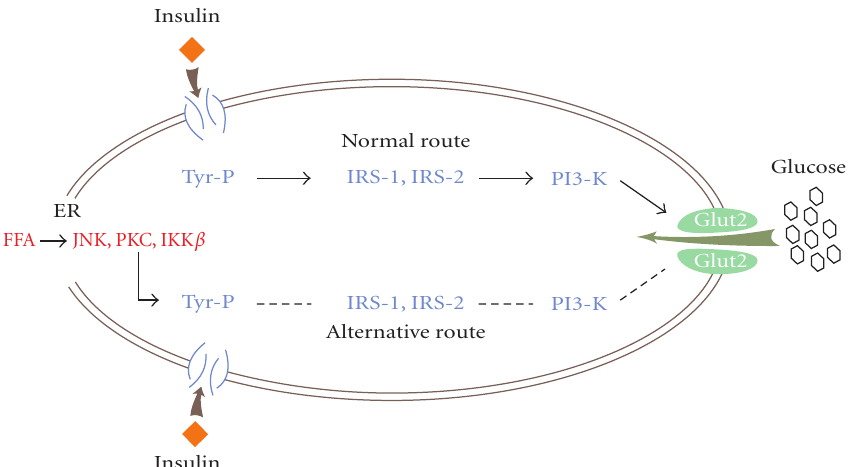
Figure 1: Mechanisms of insulin resistance (adapted from Science Oxcan et al., 2004). The figure shows both normal and alternative route of entry of glucose into the cell. With the increase of nonoxidized fatty acids by the liver, there is a change in the mechanism of tyrosine phosphorylation, and the glucose route of entry into the cell is impaired. Thereafter, intracellular insulin resistance occurs because glucose cannot enter the cell. The insulin resistance is associated with reduced expression of IRS1 and IRS2. These receptors are proteins of a family of ligands and molecules that connect insulin receptors to a cascade of reactions that allow entry of glucose into the cell. FFA: free fatty acids, P-Tyr: tyrosine, PI3-K: phosphatidylinositol kinase, ER: endoplasmic reticulum, JNK: Jun N-terminal kinase, IKK β : inhibitor of nuclear factor kappa-b kinase subunit b, PKC: protein kinase C, IRS1 and IRS2: insulin receptor substrates 1 and